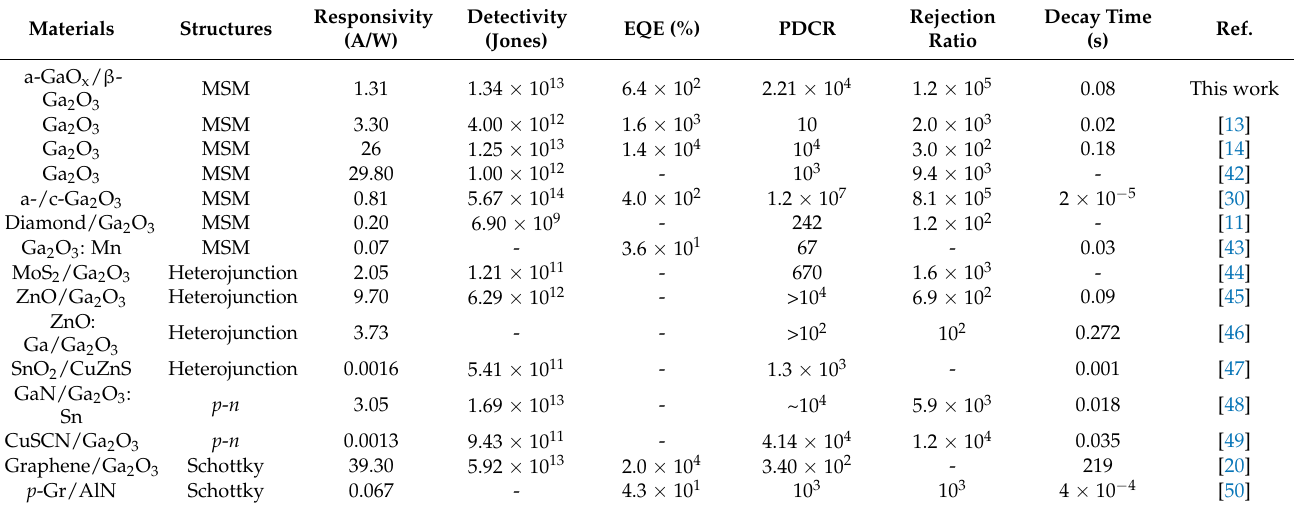
Table 1. Detailed comparison between previously reported Ga 2 O 3 PDs with the present mixed-phase Ga 2 O 3 solar-blind DUV